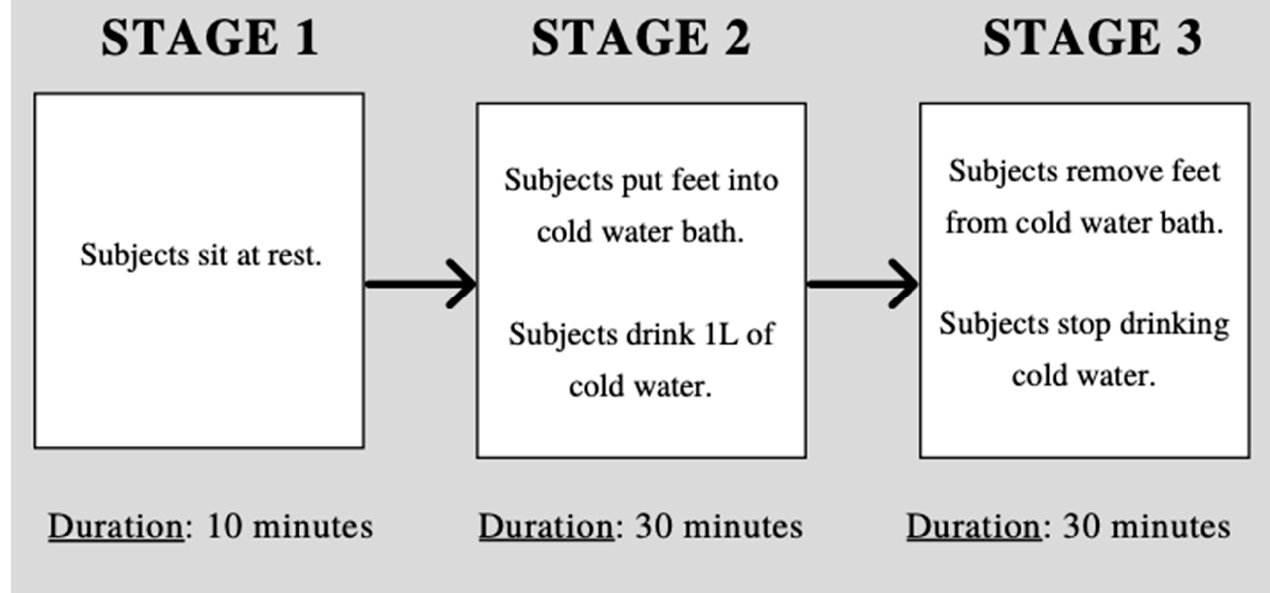
Figure 2. Flowchart describing the experimental protocol.